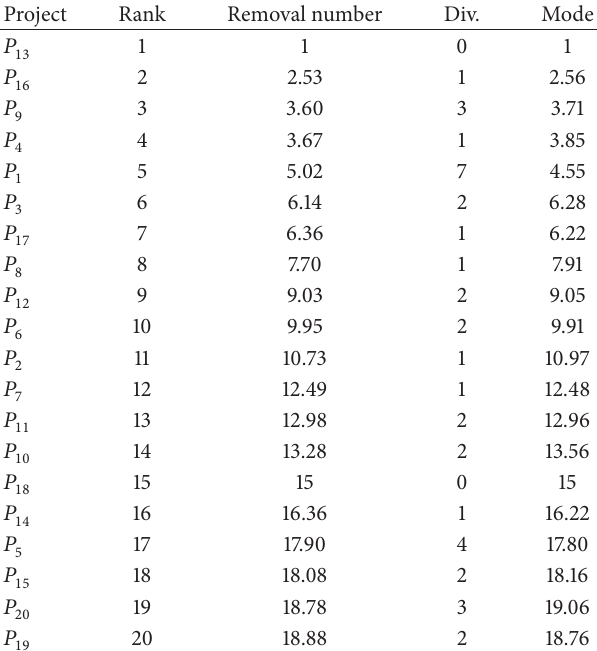
Table 6: Overall rankings of the R&D projects with Parkash entropy measure using removal number, dispersion, and modal value. Project Rank